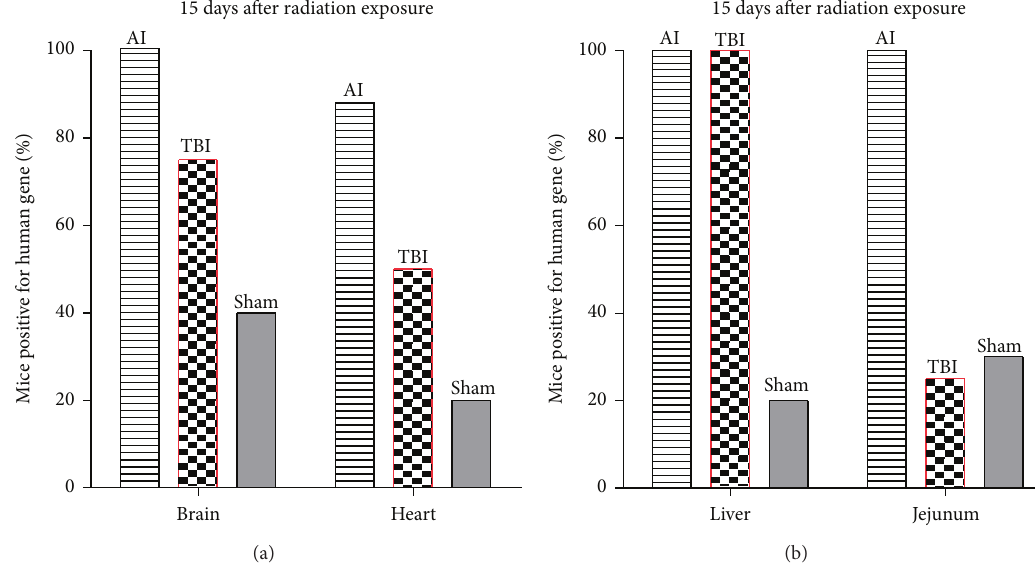
Figure 4: Radiation exposure promotes optimal chemotaxis of MSC. The percentage was calculated 15 days after radiation exposure and compared according to the irradiation configuration (abdominal irradiation (AI), represented in gray strips; total body irradiation (TBI) in red; and sham control group in gray). The histogram (a) represents the presence of the human beta-globin gene in organs outside the abdominal area such as the brain and heart. The histogram (b) represents the presence of the human gene in abdominal pelvic organs such as the liver and jejunum. Each group consisted in 10 animals. 15 days after AI, 100% of brain and 83% of hearts have human DNA. AI resulted in a mobilization of injected human stem cells on all the body via the vasculature system promoting communication into and between